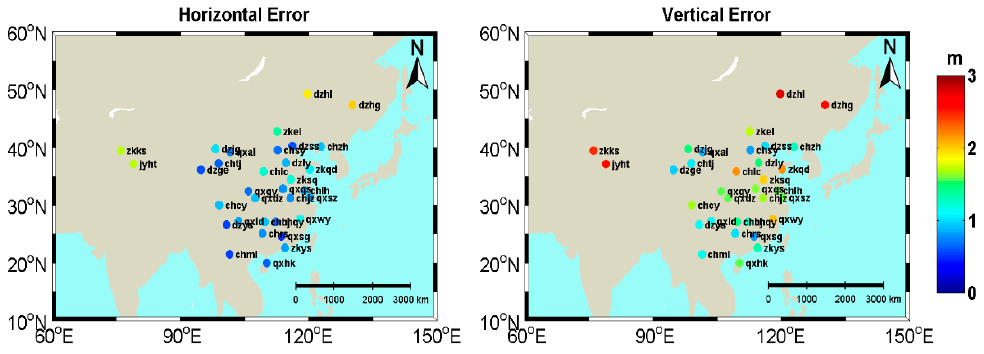
Figure 12. BDS real-time single-frequency PPP positioning accuracy at the 95% confidence level.